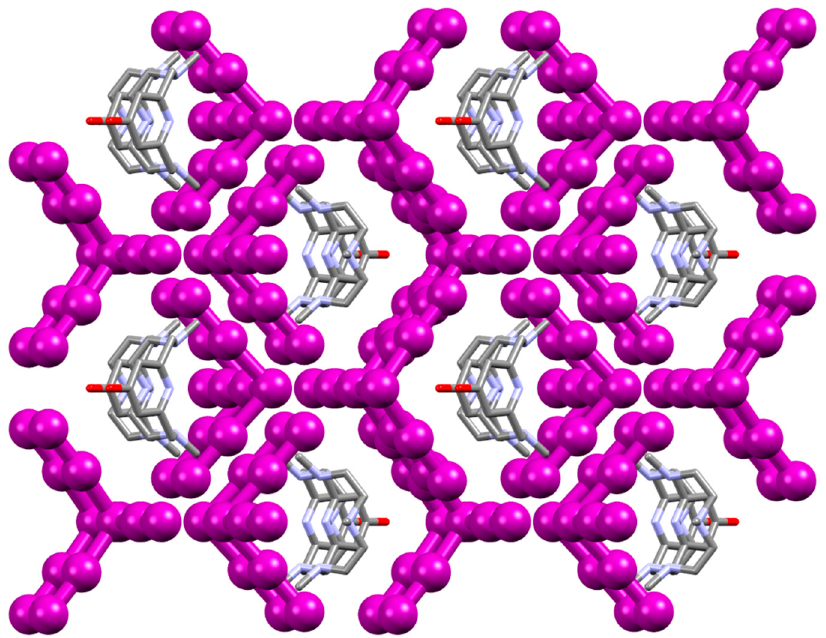
Figure 9. Schematic depiction of the distorted cubic lattice (yellow) formed by heptaiodide anions around the H 2 L–Me 32+ counterions (left) and space filling version of the same view showing the total encapsulation of the ligand (right). Color code: grey, C; cyan, N; red, O; violet, I; different shades of violet are used to help identifying discrete I 7 − ions.